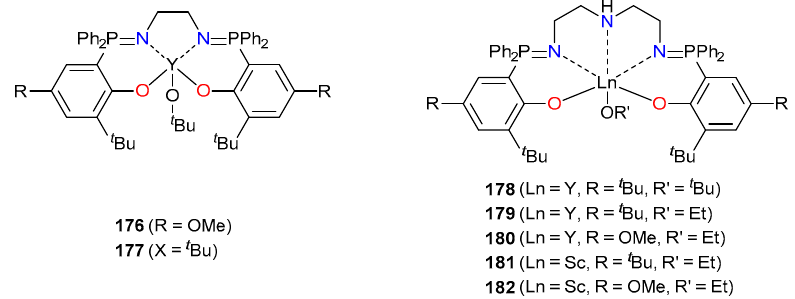
Figure 32. Tetra- and pentadentate phosphasalen Y and Sc complexes [92,93].